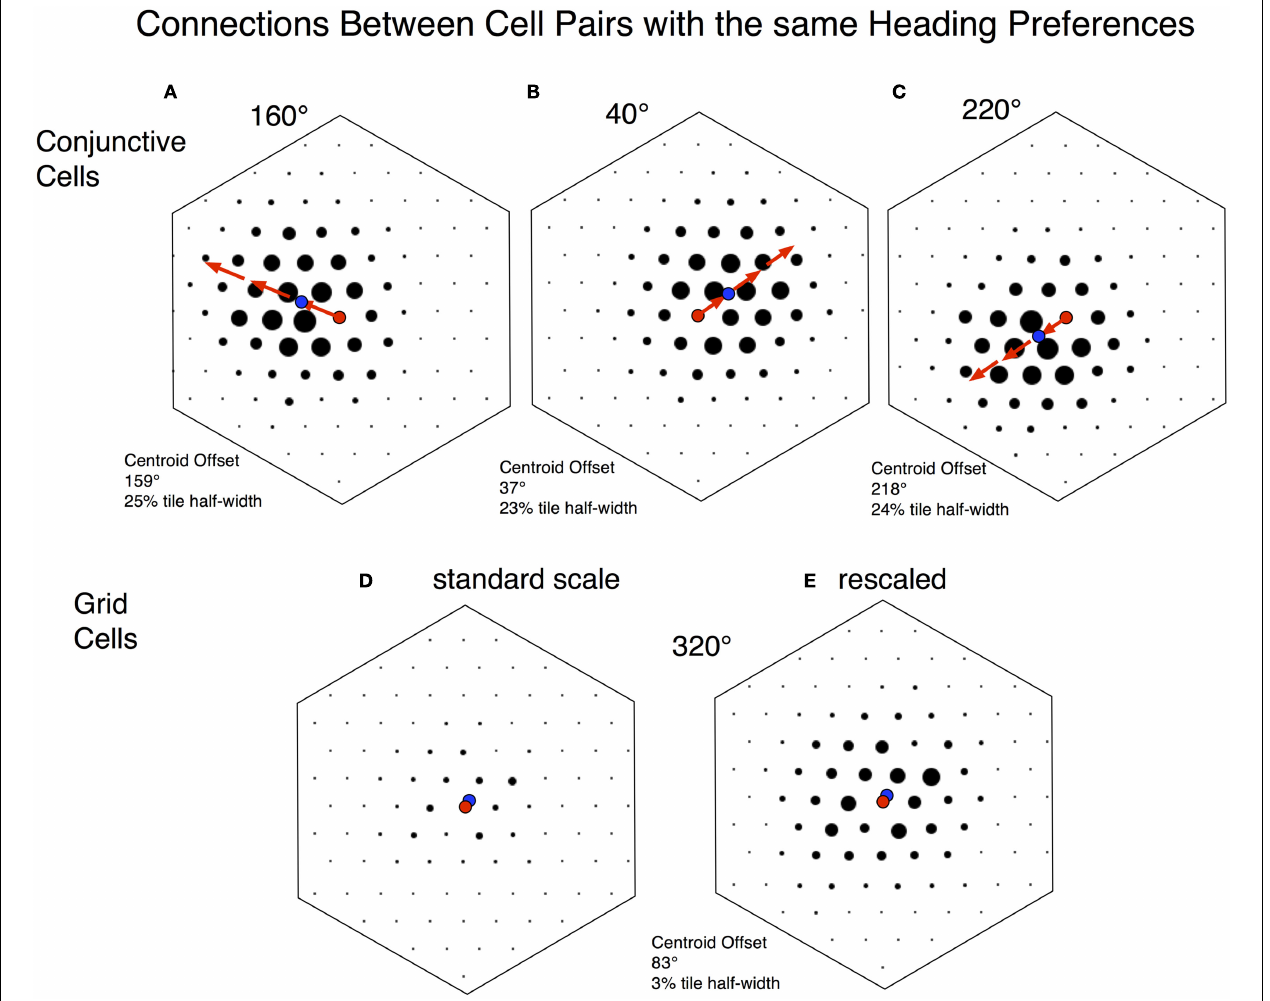
two panels (D,E) are from a simulated 30min session with 1800 grid cells in a rigid module.These cells were distributed across 100 phases. For each phase location, 18 arbitrary directional identifiers were assigned that had no influence on the cell’s behavior. (A–C) are plots from origin cells with heading preferences of 160˚, 40˚, and 220˚ respectively.The noteworthy feature of each plot is that the density of strong connections is near the center, but displaced from the center.The direction and distance of displacement is calculated by computing a centroid (center of mass) for the connections (blue dot).The distance of centroid displacement was ∼ 25% of the maximal distance to the edge of the hexagon.The direction of displacement for all three plots is very close to the direction of the common heading preference for the conjunctive cells. (D) Is a similar plot from a single grid cell.The directional preference is an arbitrary assignment made to each cell and does not reflect firing preferences.The point to note is that all of the connection strengths (black circles) are low. (E) Is a remapping of the same data, but increasing the dot-scale by a factor of three.This shows that relatively stronger connections are close to the central cell. Both panels show that the magnitude of displacement of centroid from center is almost